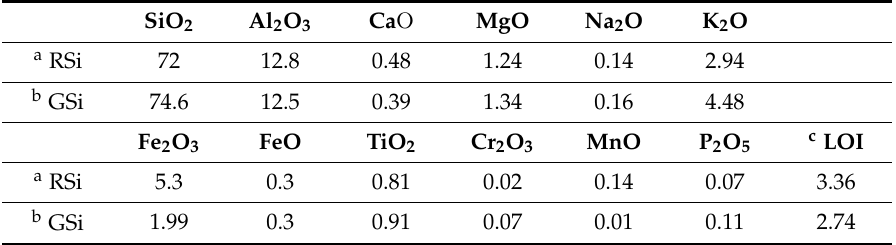
Table 1. Average chemical composition of the red siltstones and sandstones of the Padun Formation of the Vendian in the research area (from 18 determinations) [34] and green siltstones of the sample GGS2-11 (depth 99.5 m), %. SiO 2 Al 2 O 3 Ca О MgO Na 2 O K 2 O a RSi 72 12.8 0.48 1.24 0.14 2.94 b GSi 74.6 12.5 0.39 1.34 0.16 4.48 Fe 2 O 3 FeO TiO 2 Cr 2 O 3 MnO P 2 O 5 c LOI a RSi 5.3 0.3 0.81 0.02 0.14 0.07 3.36 b GSi 1.99 0.3 0.91 0.07 0.01 0.11